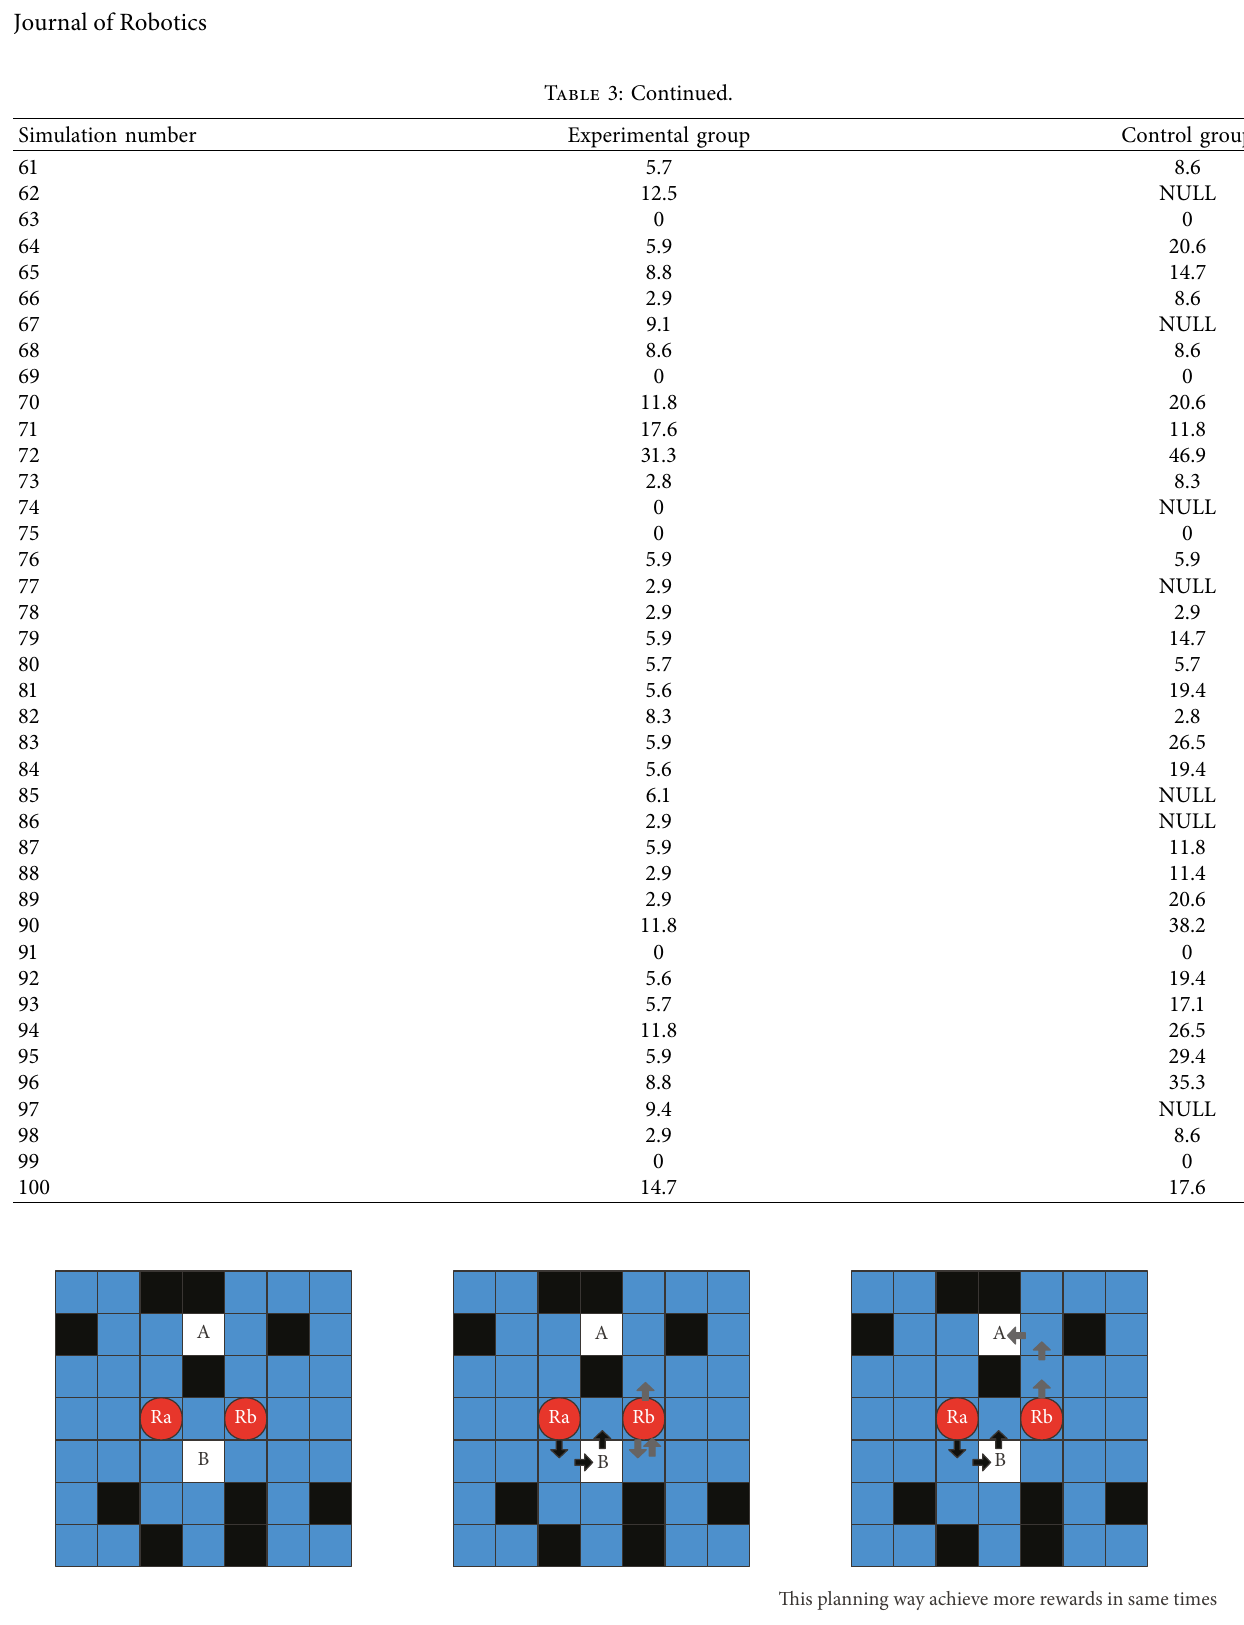
Figure 7: The deduction method works with two close